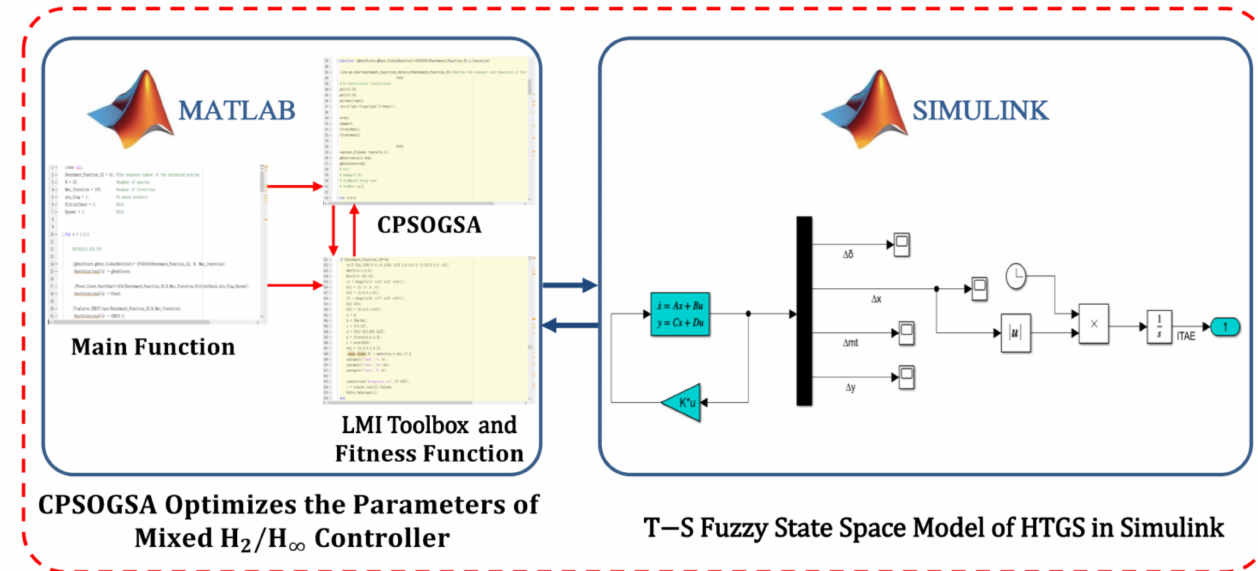
Figure 5. Schematic view of MATLAB/Simulink-based HTGS